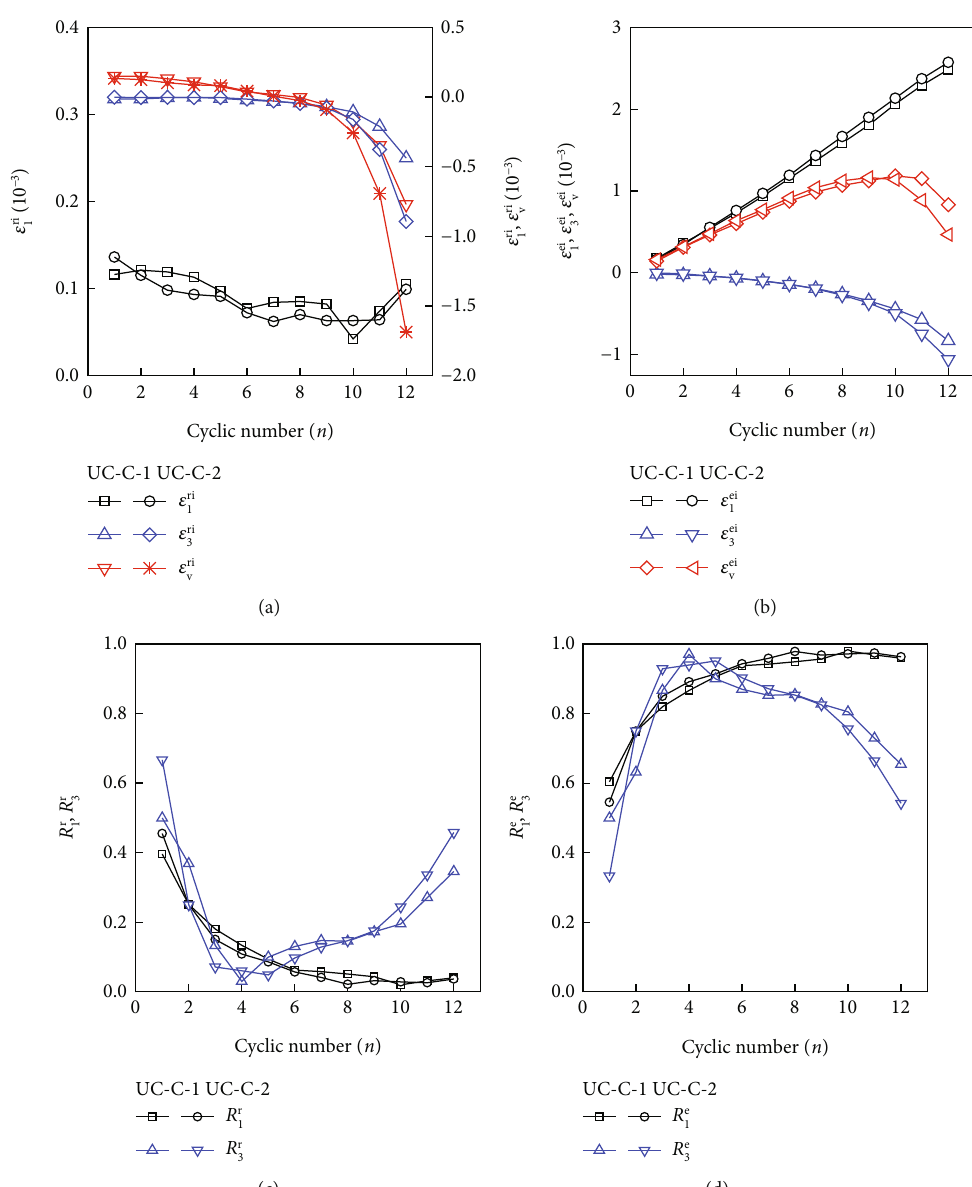
Figure 5: Residual (elastic) strain and their ratios of sandstone under uniaxial cyclic loading-unloading compression: (a) residual strain, (b) elastic strain, (c) proportion of residual strain, and (d) proportion of elastic